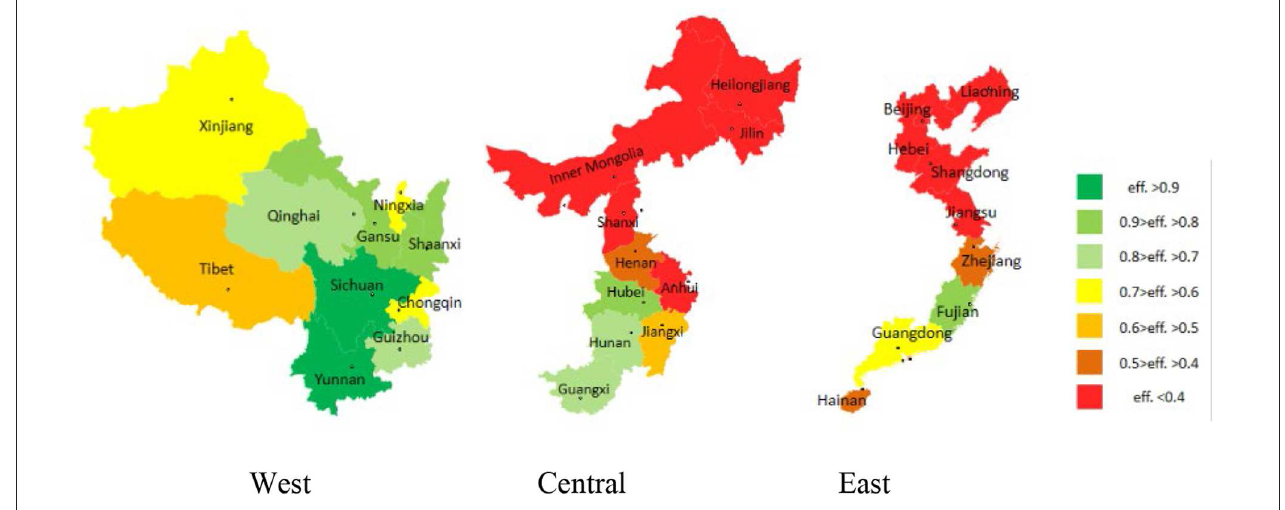
FIGURE 3 | Map of regional total efficiency.